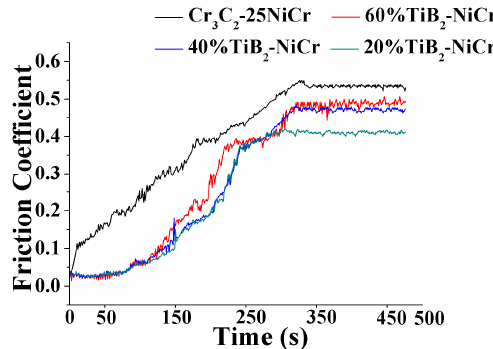
Figure 6. Coefficient of friction of coatings.